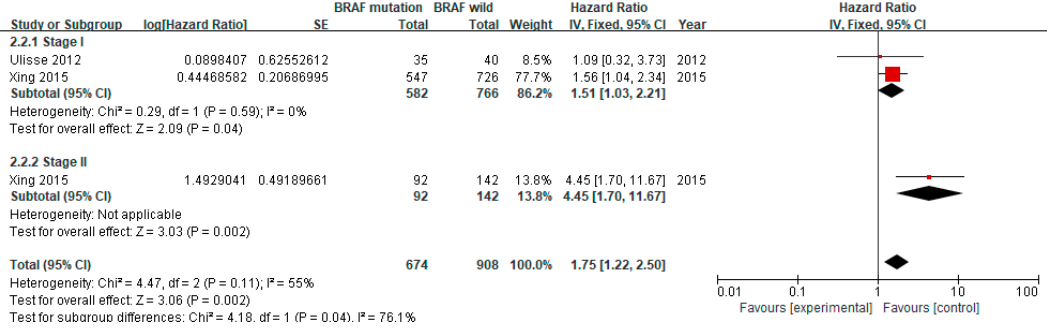
Figure 5. Forest plot of the subgroup analysis according to the tumor stage.